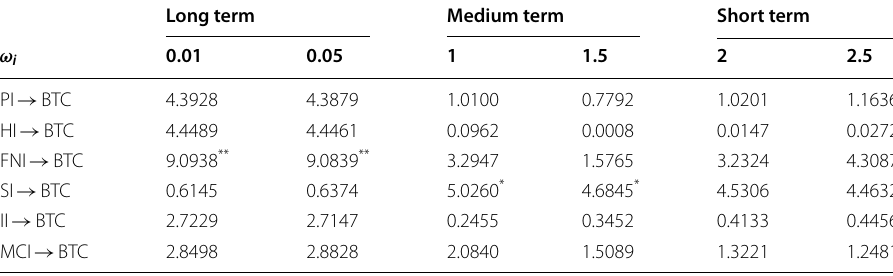
Table 10 Results of frequency domain causality test from RavenPack coronavirus-related indices to Bitcoin